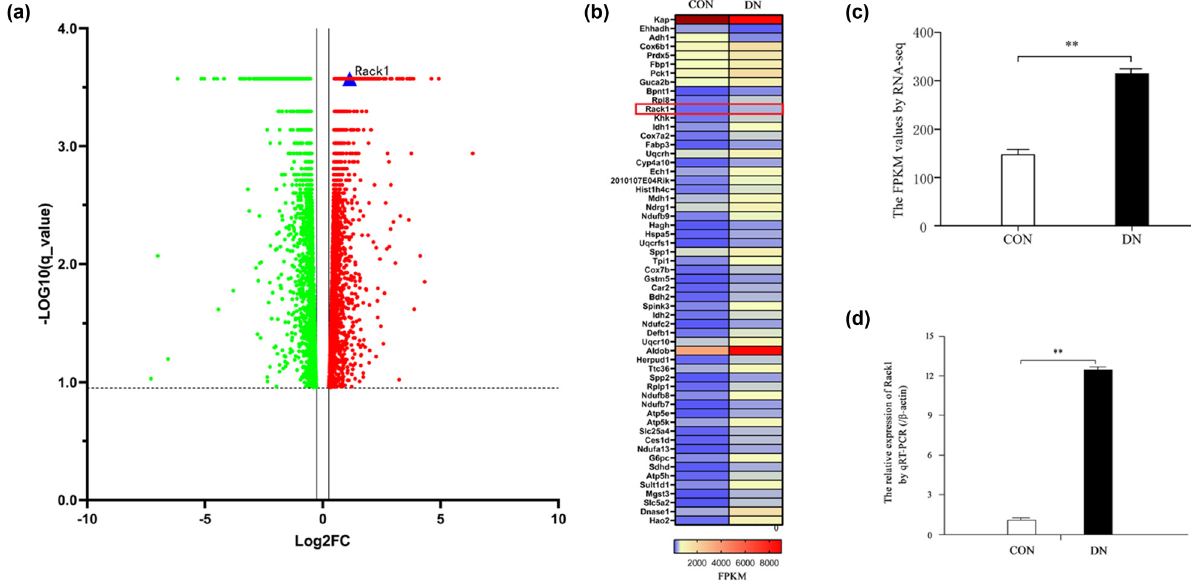
Figure 1: Rack1 was highly expressed in DN in vivo and in vitro . ( a ) The mRNA was examined by RNA - seq ( q < 0.05 ) in the kidney tissues of db/db DN mice ( n = 3 for 12 weeks ) and normal control mice ( n = 2 for 12 weeks ) . A total of 6,820 mRNAs were dysexpressed in the DN group, including 3,905 up - expressed and 2,915 down - expressed mRNAs ( q - value < 0.05 ) . ( b ) Fifty - seven DN - related genes were found with high fold changes (| fold change | > 1 ) and high values of FPKM in both two groups ( FPKM > 100 ) by RNA - seq. ( c ) The expression of Rack1 was signi fi cantly increased in renal tissues of the DN mice group compared with that in the normal controls by RNA - seq ( ** p < 0.01 ) . ( d ) The expression of Rack1 was signi fi cantly increased in renal tissues of the DN mice group compared with that in the normal controls by qRT - PCR. The data are representative of three independent experiments ( ** p < 0.01 )